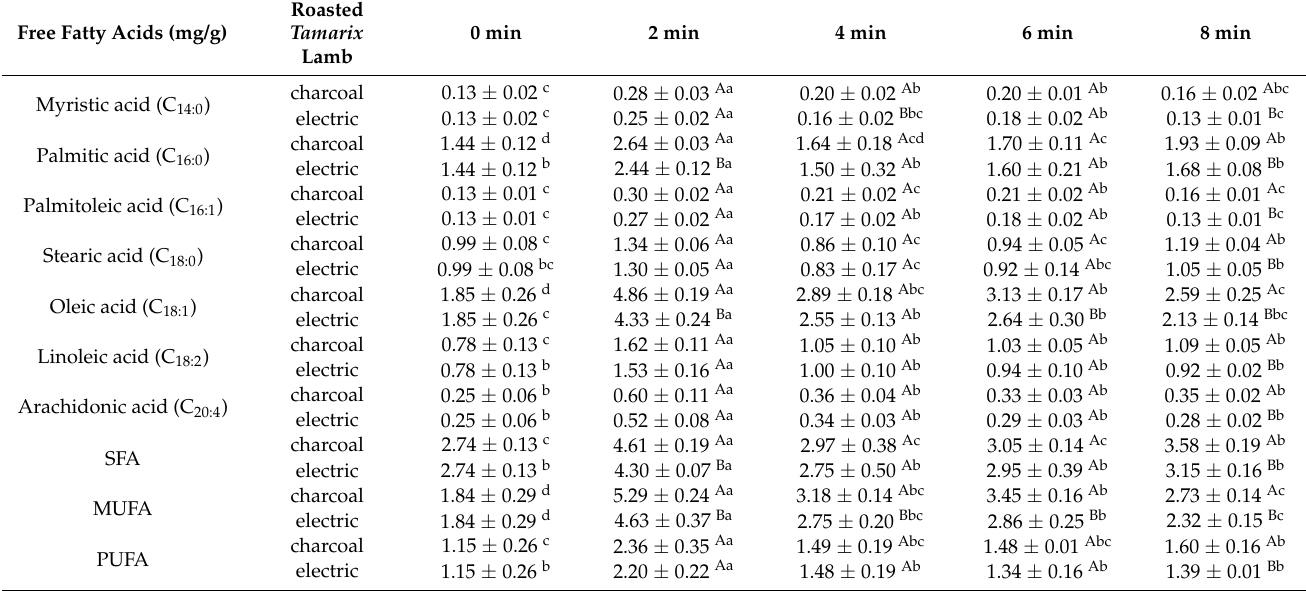
Table 1. Changes of free fatty acids in tamarix lamb roasted by charcoal or